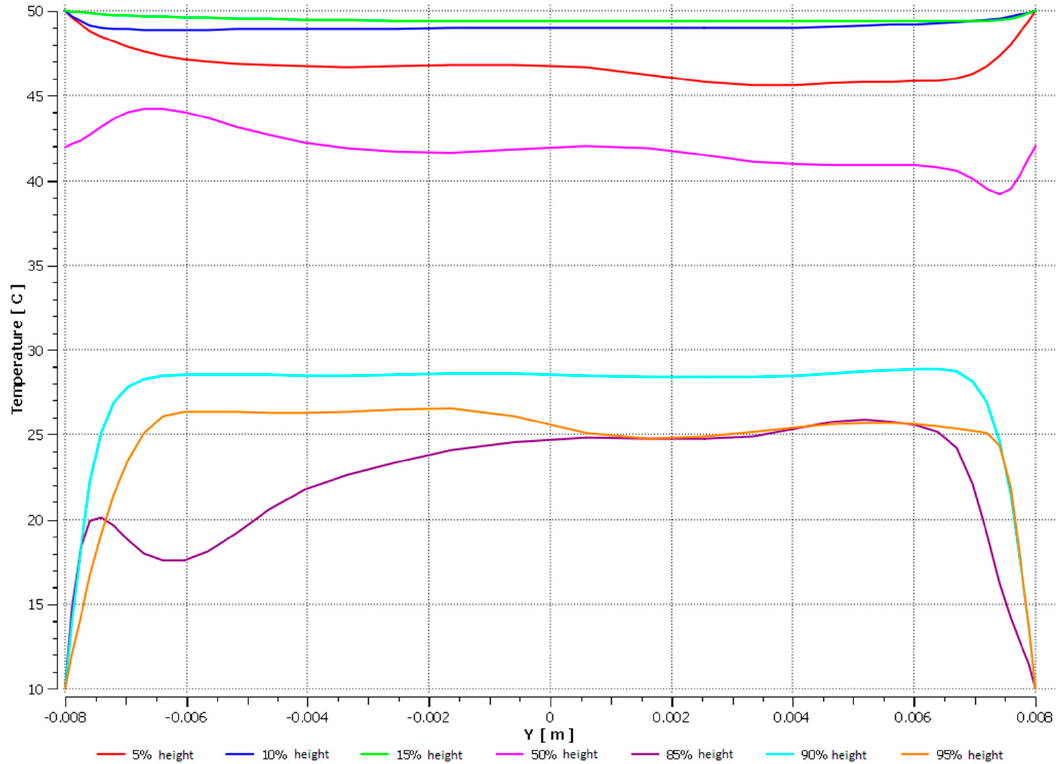
Figure 15. Temperature distribution along the cross-section.